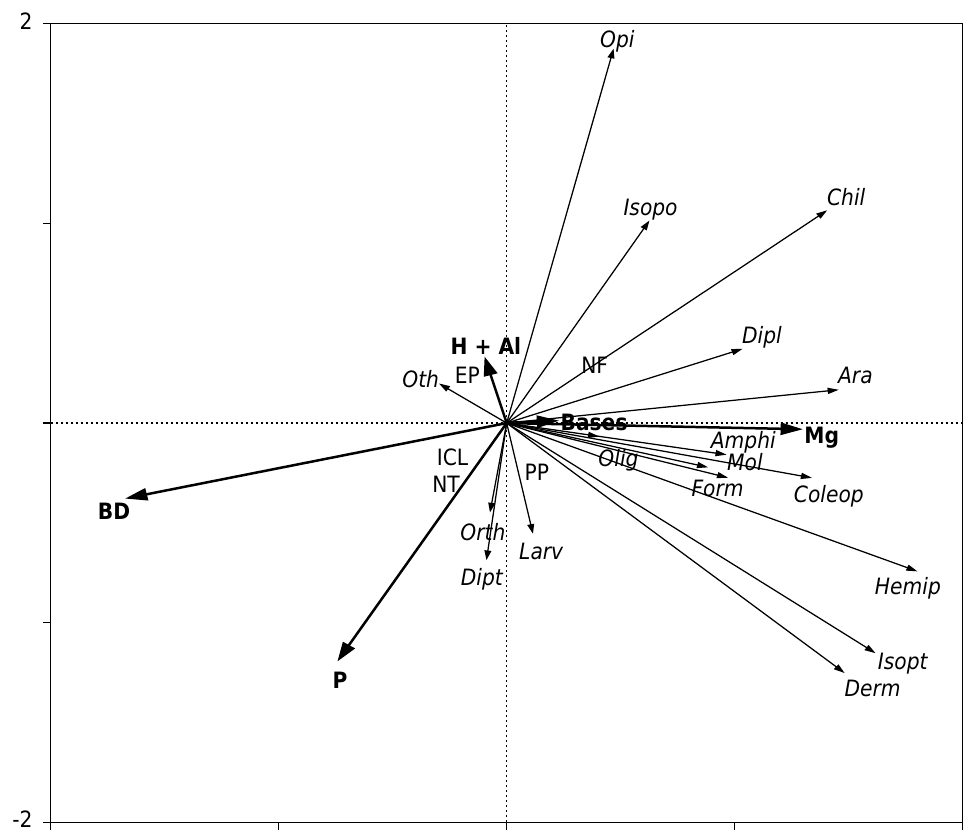
Figure 6. Principal component analysis (PCA) to differentiate native forest (NF), eucalypt plantations (EP), perennial pasture (PP), integrated crop-livestock system (ICL), and no-tillage (NT) based on samples collected in the winter, in the eastern region of Santa Catarina, Brazil. Vectors in bold represent the soil physical (BD: bulk density) and chemical properties (Mg: magnesium, P: phosphorus, H+Al: potential acidity, base saturation (Bases). In italics are the main macrofaunal groups: Oligochaeta ( Olig ), Opiliones ( Opi ), Formicidae ( Form ), Coleoptera ( Coleop ), total of other larvae ( Larv ), Molusca ( Mol ), Diplopoda ( Dipl ), Chilopoda (Chil ), Isopoda (Isopo), Araneae ( Ara ), Amphipoda ( Amphi ), Isoptera ( Isopt ), Orthoptera ( Orth ), Hemiptera ( Hemip ), Dermaptera ( Derm ), Diptera ( Dipt ), and total of other less frequent groups ( Oth